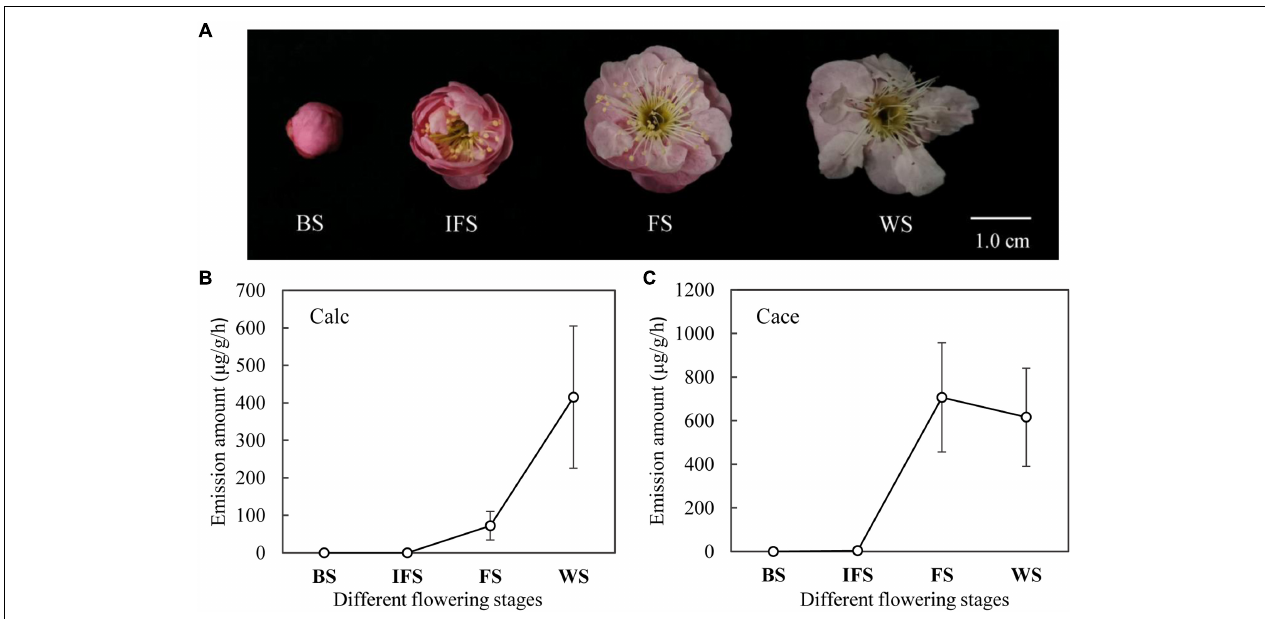
FIGURE 1 | The release of cinnamyl alcohol and cinnamyl acetate at different flowering stages of Prunus mume ‘Fenh.’ (A) Flowers of P. mume ‘Fenhong Zhusha’ at different flowering stages: BS, budding stage; IFS, initial flowering stage; FS, full-blooming stage; and WS, wilting stage. (B,C) Dynamic changes of cinnamyl alcohol (Calc) and cinnamyl acetate (Cace) released at different flowering stages of P. mume , respectively.